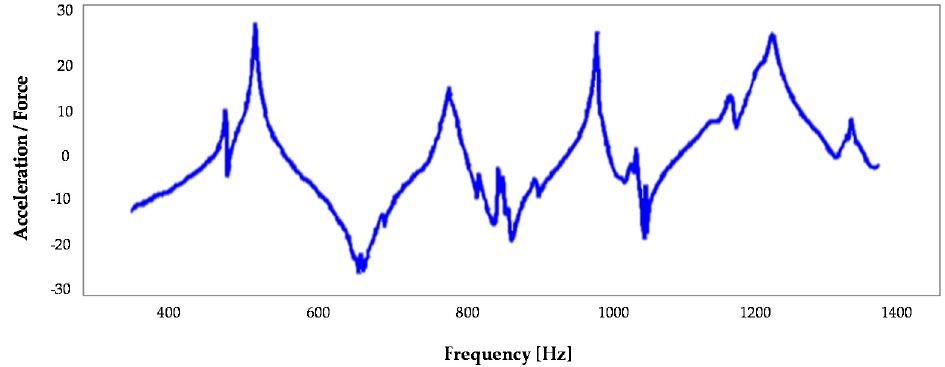
Figure 7. The frequency response function (FRF) of the excited point (centre of ram) in the Y direction.